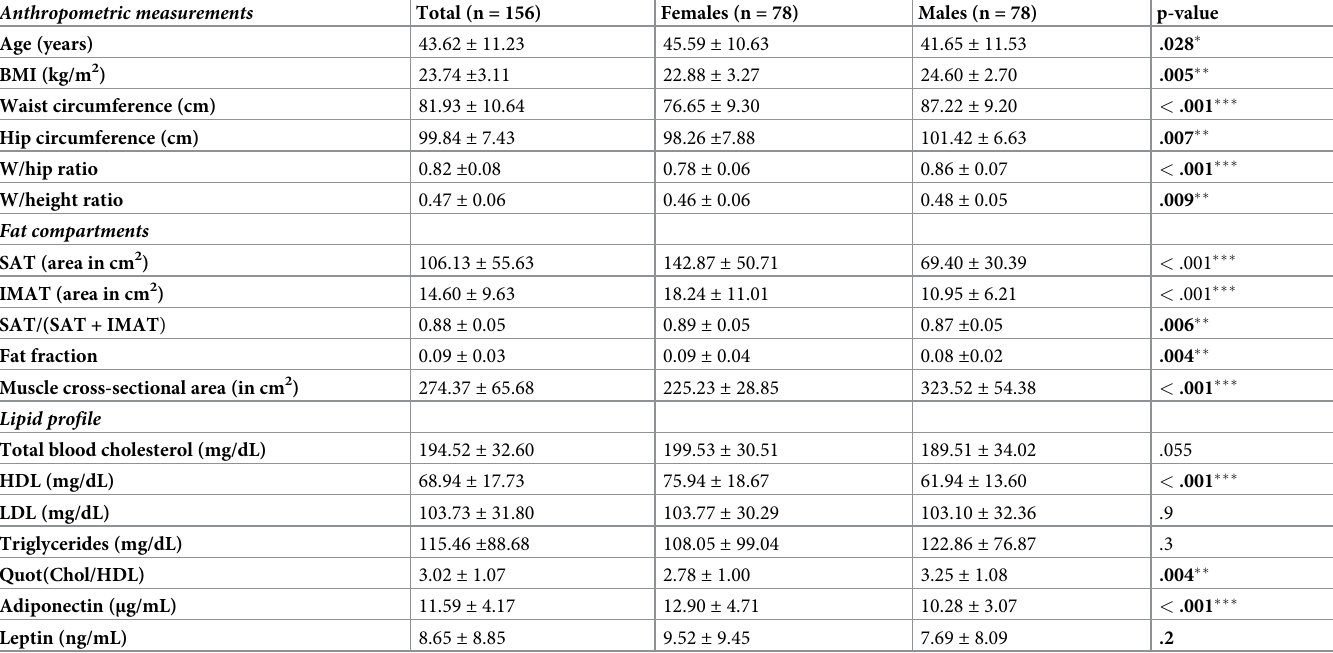
Results of the fat segmentation and the laboratory parameters are presented. p-values indicate sex differences (values are reported as mean ± standard deviation